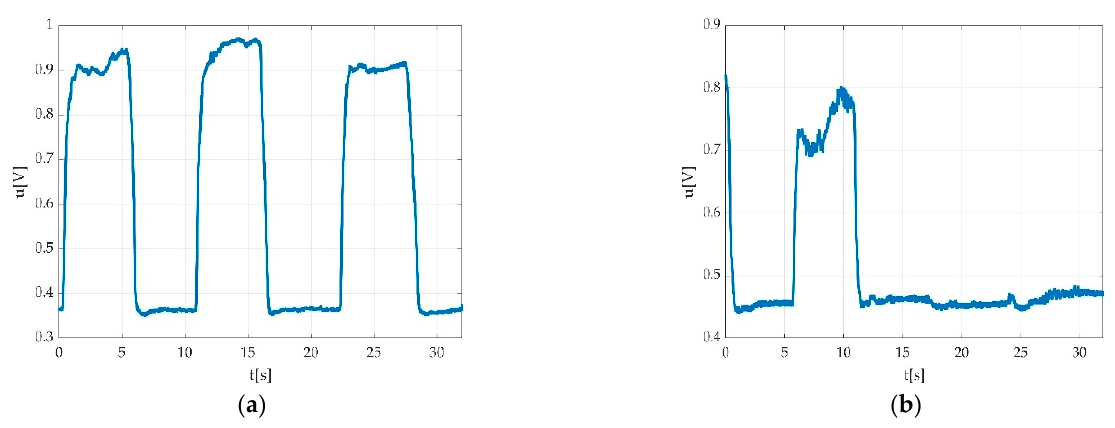
Figure 3. Example of signal acquisition during: ( a ) three consecutive MVICs during plantar flexion with obtained offset (red intermittent line) during acquisition/familiarization with measurement procedure; maximal value of voltage (peak voltage); ( b ) one muscle effort for acclimatisation of participant with the requested type of contraction.